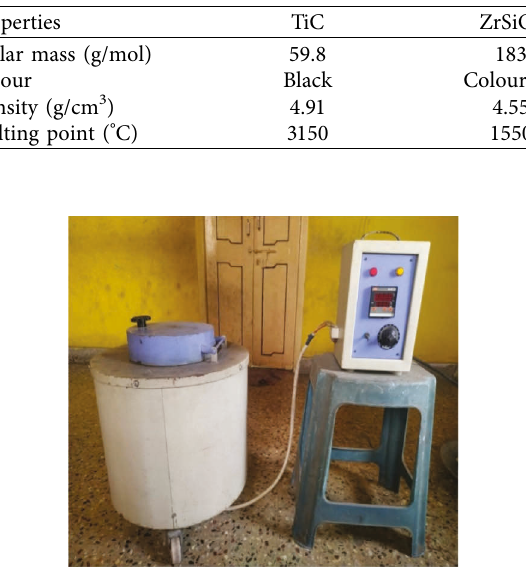
Table 2: Reinforcement properties.